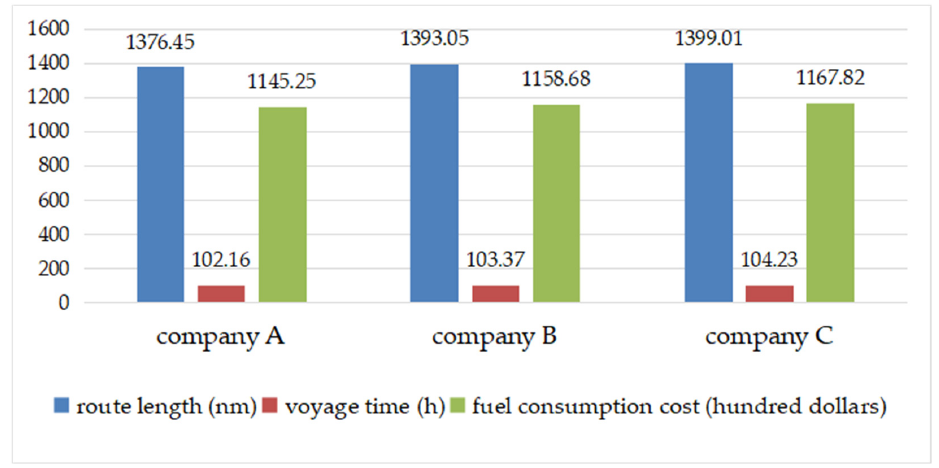
Figure 8. Comparison of three companies in route length, voyage time, and fuel consumption cost.